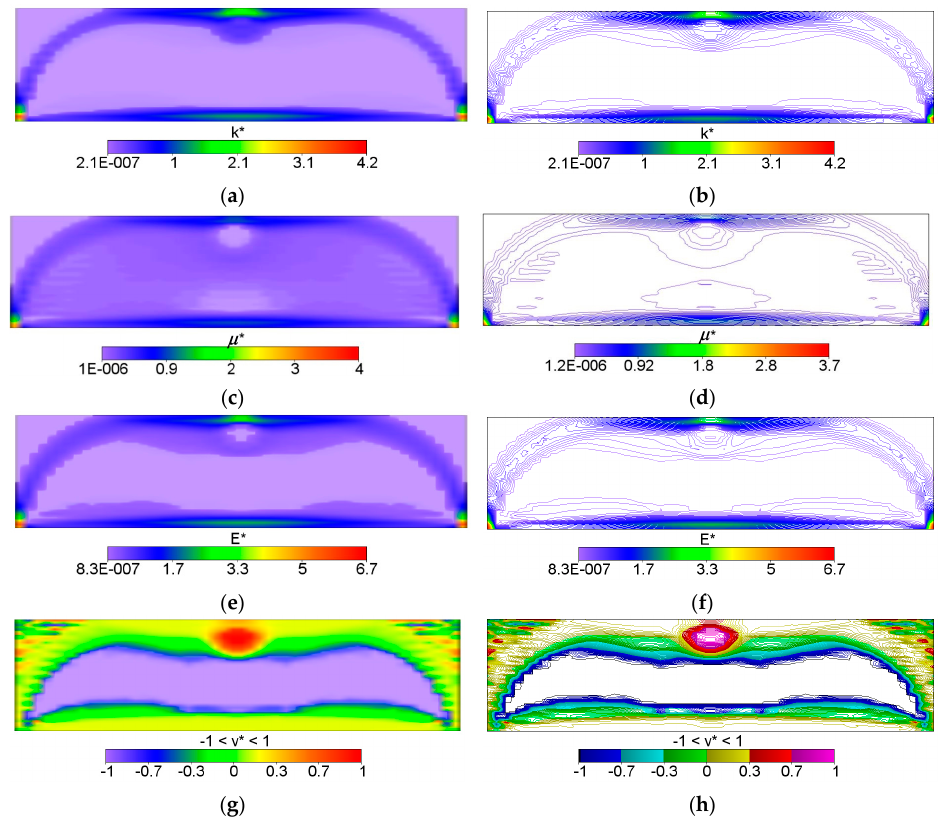
Figure 2. First six figures: Volume-render ( left ); and contour ( right ) views of the optimal and relative (i.e., divided by E 0 ) layouts of ( a , b ) bulk k *; ( c , d ) shear μ * and ( e , f ) Young’s E * moduli, respectively. The last two figures: ( g ) Volume-render and ( h ) contours views of optimal distribution of the optimal Poisson’s ratio ν *.